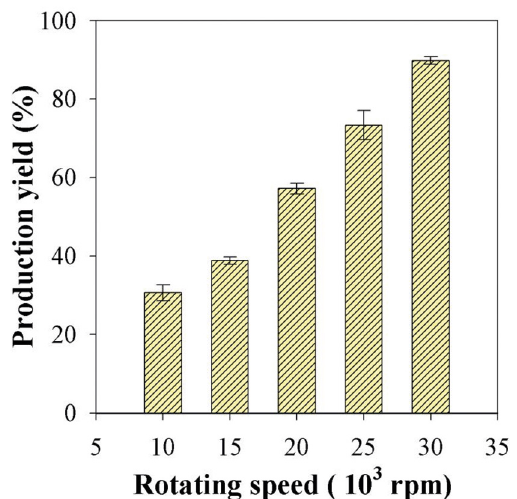
Figure 9. Effect of rotation speed on production yield of zinc powder, with 40 mm diameter flat disc, 50 kg/hr melt feed rate, and 550 o C melt temperature.